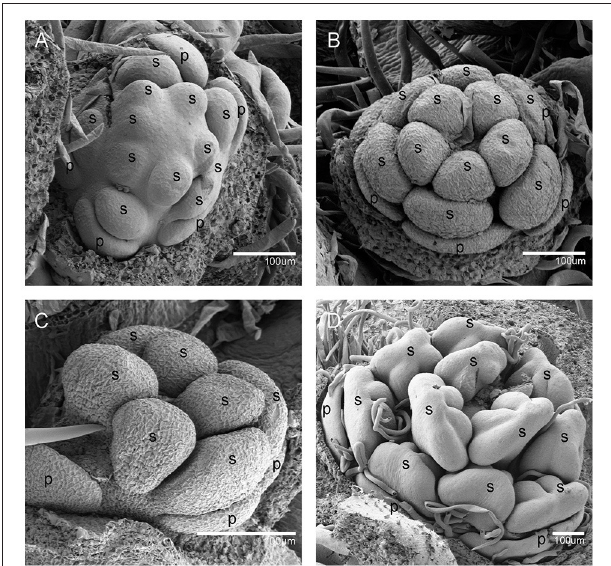
FIGURE 3 | The development of the male V. fordii flower during sex differentiation. The sepal primordia have been removed. (A,B) Stage 7 in the male flower: the floral meristem was arrested and oval-shaped stamen primordia were formed. (C) Stage 8: stamen primordia were transformed from oval-shaped to tongue-shaped and stamens became stalked. (D) Stage 9: anthers of male flowers formed convex protrusions on the inner surface. p, petal; s,